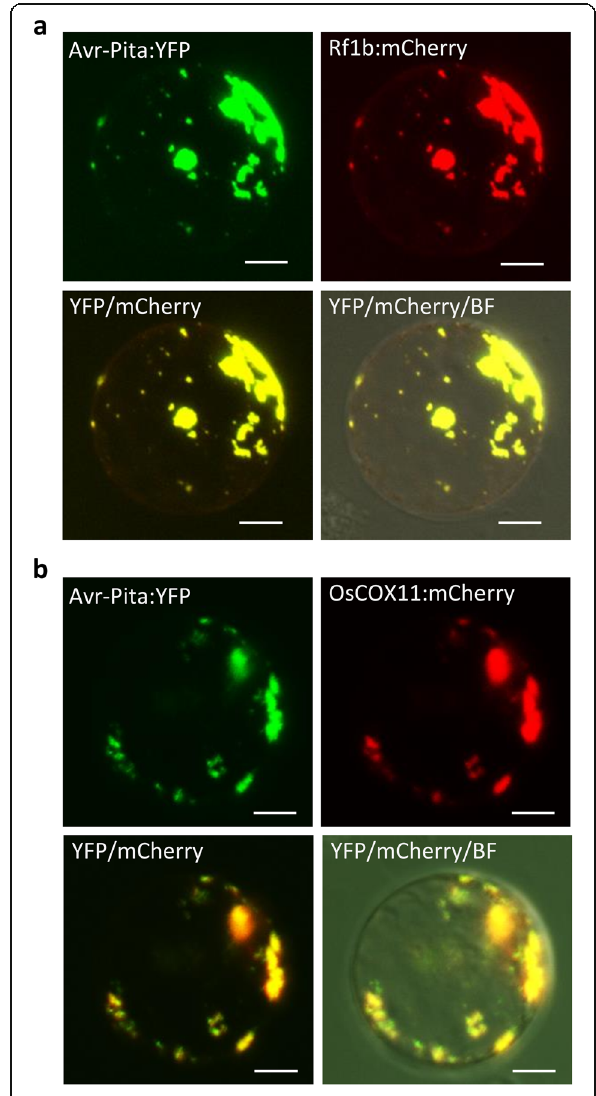
Fig. 3 Avr-Pita and OsCOX11 co-localize to rice mitochondria. a Avr- Pita:YFP and mitochondrial marker Rf1b:mCherry were co-expressed in rice protoplasts. YFP and mCherry fluorescent signals overlapped in the mitochondria. b Avr-Pita:YFP and OsCOX11:mCherry were co- expressed in rice protoplasts. YFP and mCherry fluorescent signals overlapped in the mitochondria. Scale bars = 10 μ